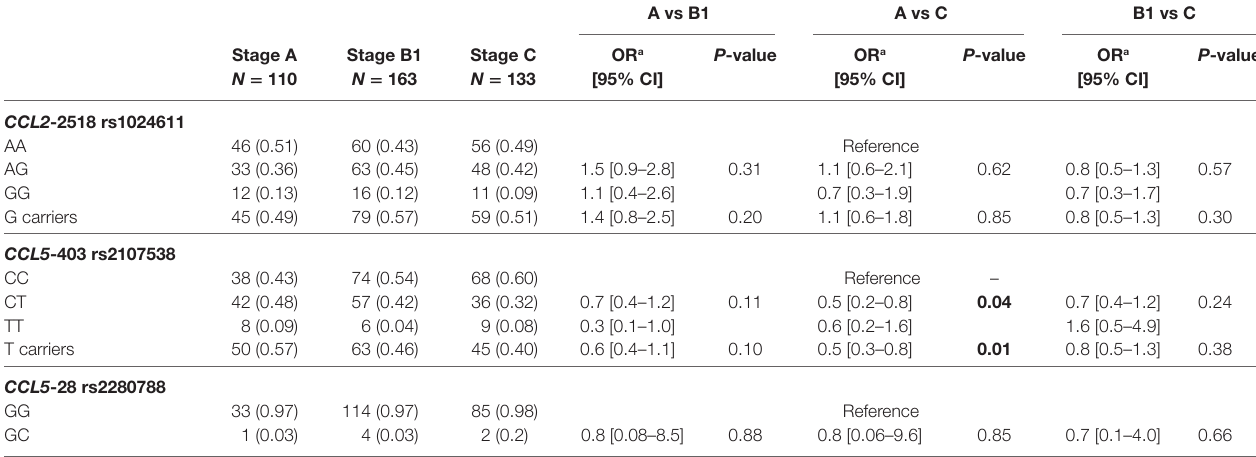
TaBle 1 | Analysis of single nucleotide polymorphisms located in the CCL2 and CCL5